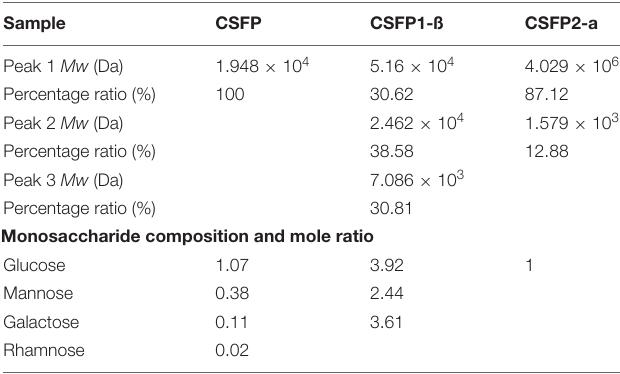
TABLE 2 | Changes in molecular weight ( Mw ) and molar ratio of monosaccharide compositions of CSFP, CSFP1- β , and CSFP2- α .